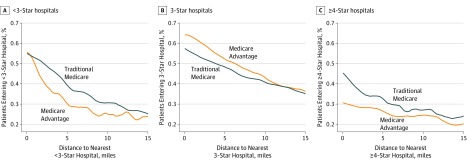
Share of Medicare Advantage and Traditional Medicare Patients Admitted to Hospitals in Neighborhoods With Different Proximity to HospitalsThe graphs include nonemergency admissions only. Lines display the percentage of people who live a given distance from a given star-rated hospital who were admitted to that star quality hospital. If there were no selection due to Medicare Advantage enrollment status, these lines would be expected to overlap. Confidence intervals are not included; however, they are tightly aligned with the estimate lines and do not overlap.